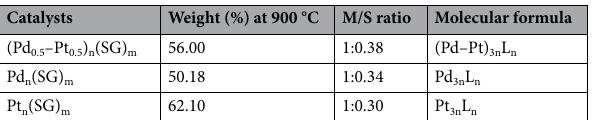
Catalysts Weight (%) at 900 °C M/S ratio Molecular formula (Pd 0.5 –Pt 0.5 ) n (SG) m